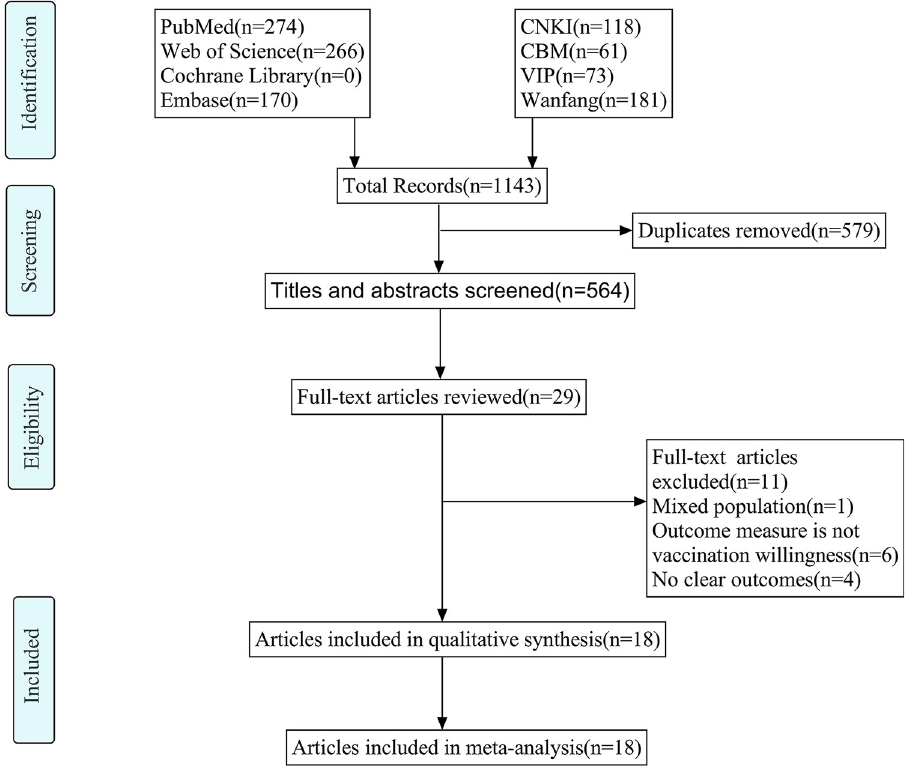
Fig 1. PRISMA flow